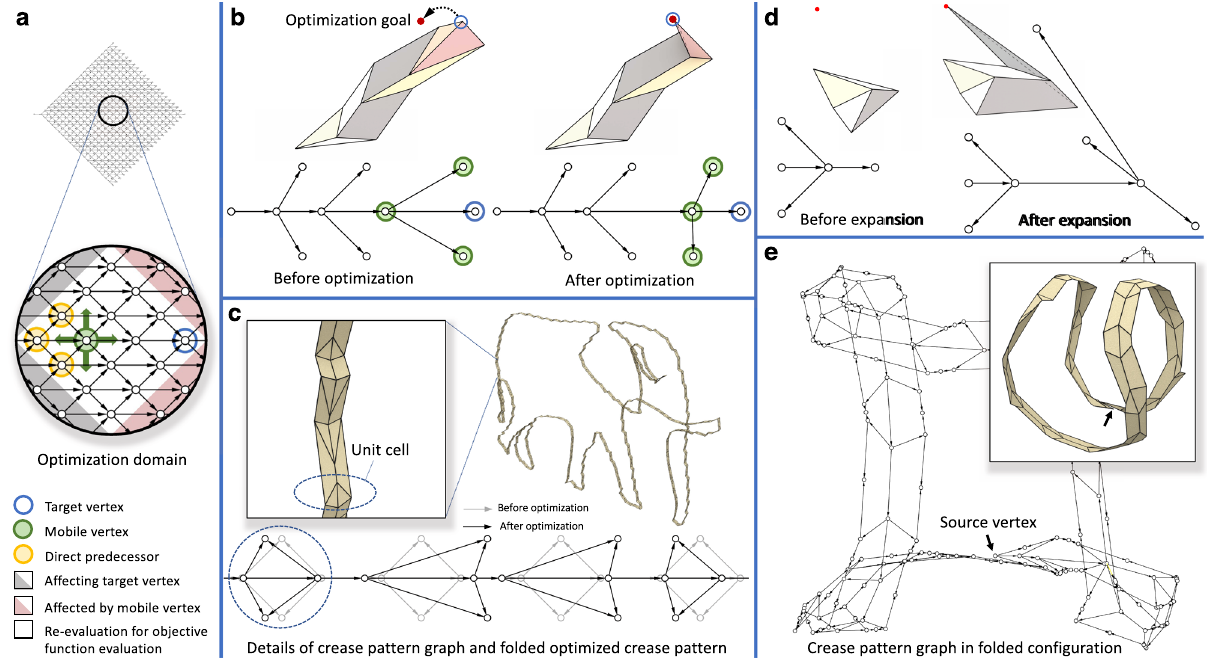
Fig. 2 Optimization and automated generation of crease patterns. a Optimization domain de fi nition in terms of vertices and their dependencies. b Crease pattern graph and folded con fi guration of a simple origami before and after optimization. The goal of the optimization problem is to place the mobile vertices such that the target vertex reaches the target point in the folded con fi guration. c Pattern that was optimized sequentially to match the shape of an elephant in its folded con fi guration. Crease pattern graph de fi ned in terms of unit cells before (grey) and after (black) optimization. d Sample crease pattern graph with folded con fi guration before and after expansion. The goal of the expansion is to reach the point marked in red. e Crease pattern graph and folded con fi guration of corresponding crease pattern that was subsequently extended to approach the shape of the seam on a tennis ball in the folded con fi guration. The crease pattern graph is shown using the vertex locations in the deformed con fi guration (the graph is shown as seen from the top view). Auxiliary vertices are shown in this